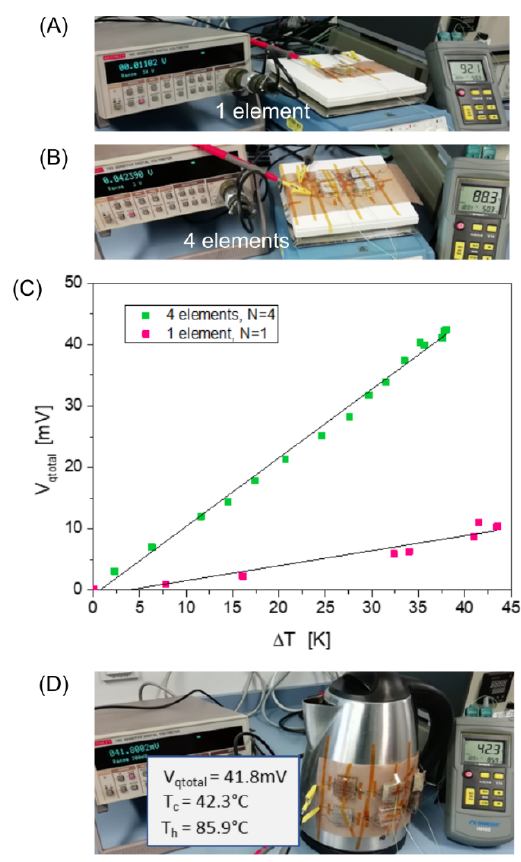
Figure 5. Output voltage V qtotal dependent on the number of interconnected elements N, ( A ) image of a measurement setup with one TE element on a hot plate, ( B ) with four TE elements on a hot plate. Spacer fabrics with conductive silver surfaces are used. N = 4, R itotal = 2 k Ω . ( C ) Total output voltages in comparison. ( D ) Example of the everyday life, a kettle with 6 textile elements with Cu surfaces.